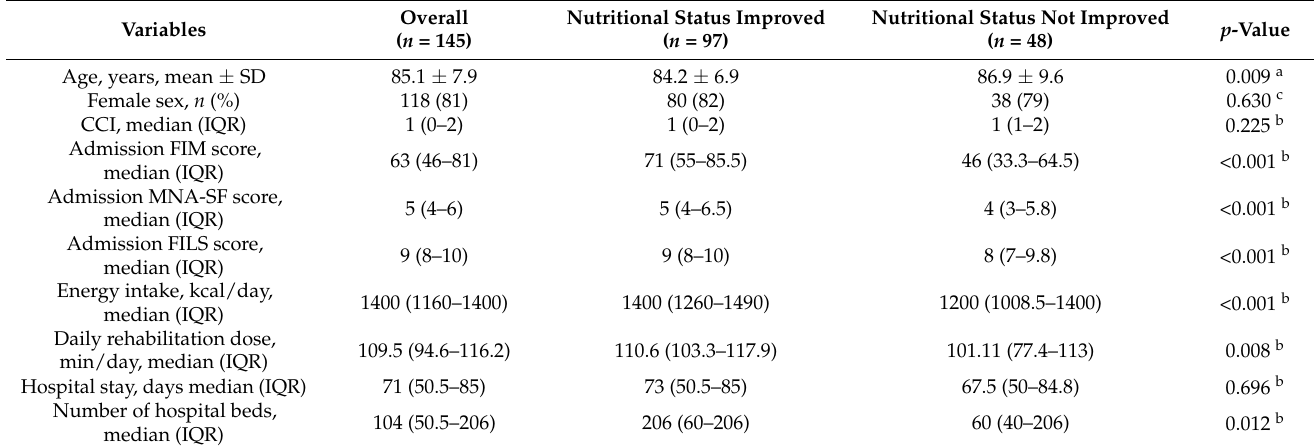
Table 1. Patient characteristics overall and by study group at